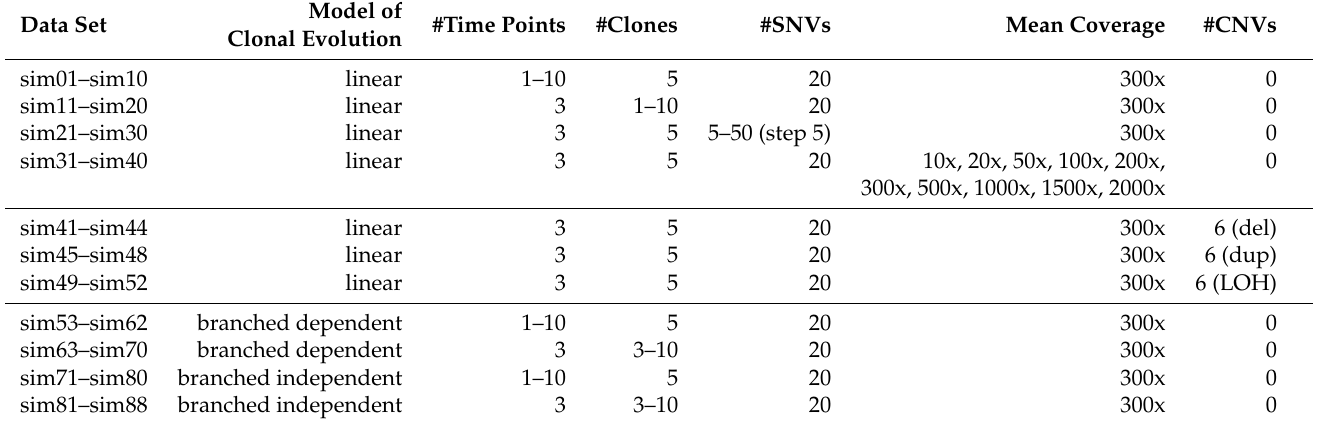
Table 1. Data sets simulated using clevRsim. Altogether, 88 data sets with 10 patients each were simulated. Simulated sets were used to evaluate performance of variant clustering tools in a basic (from sim01 to sim40) and an advanced setting (from sim41 to sim 52). Additionally, the performance of tools for clonal evolution tree reconstruction was evaluated (from sim01 to sim20 and from sim53 to